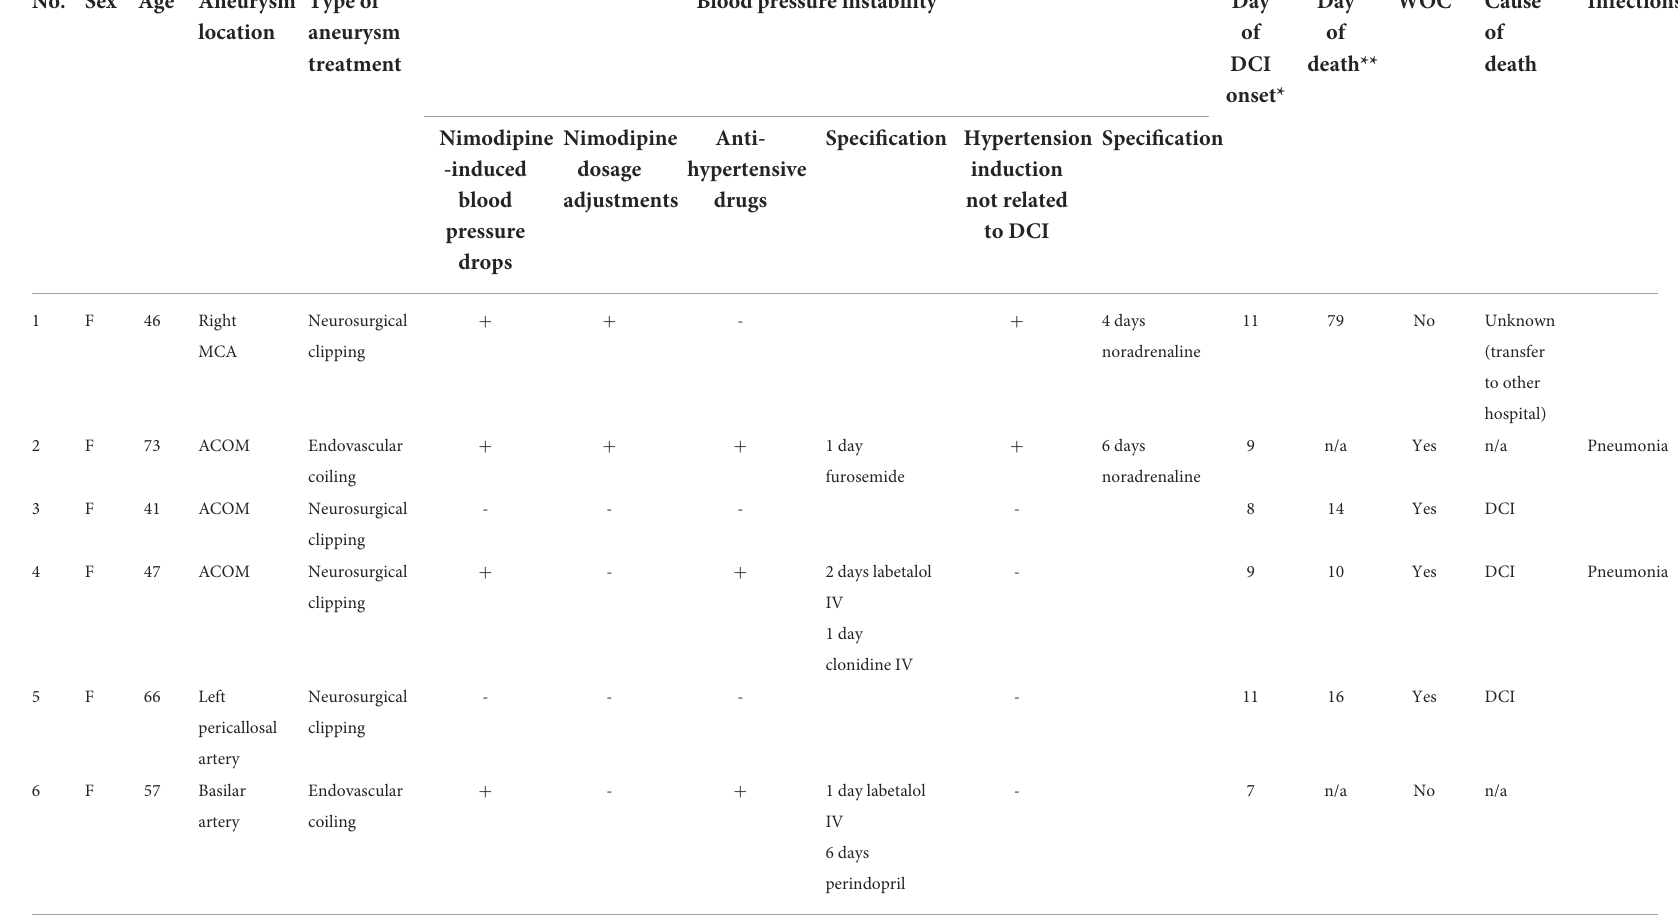
TABLE 2 Individual patient